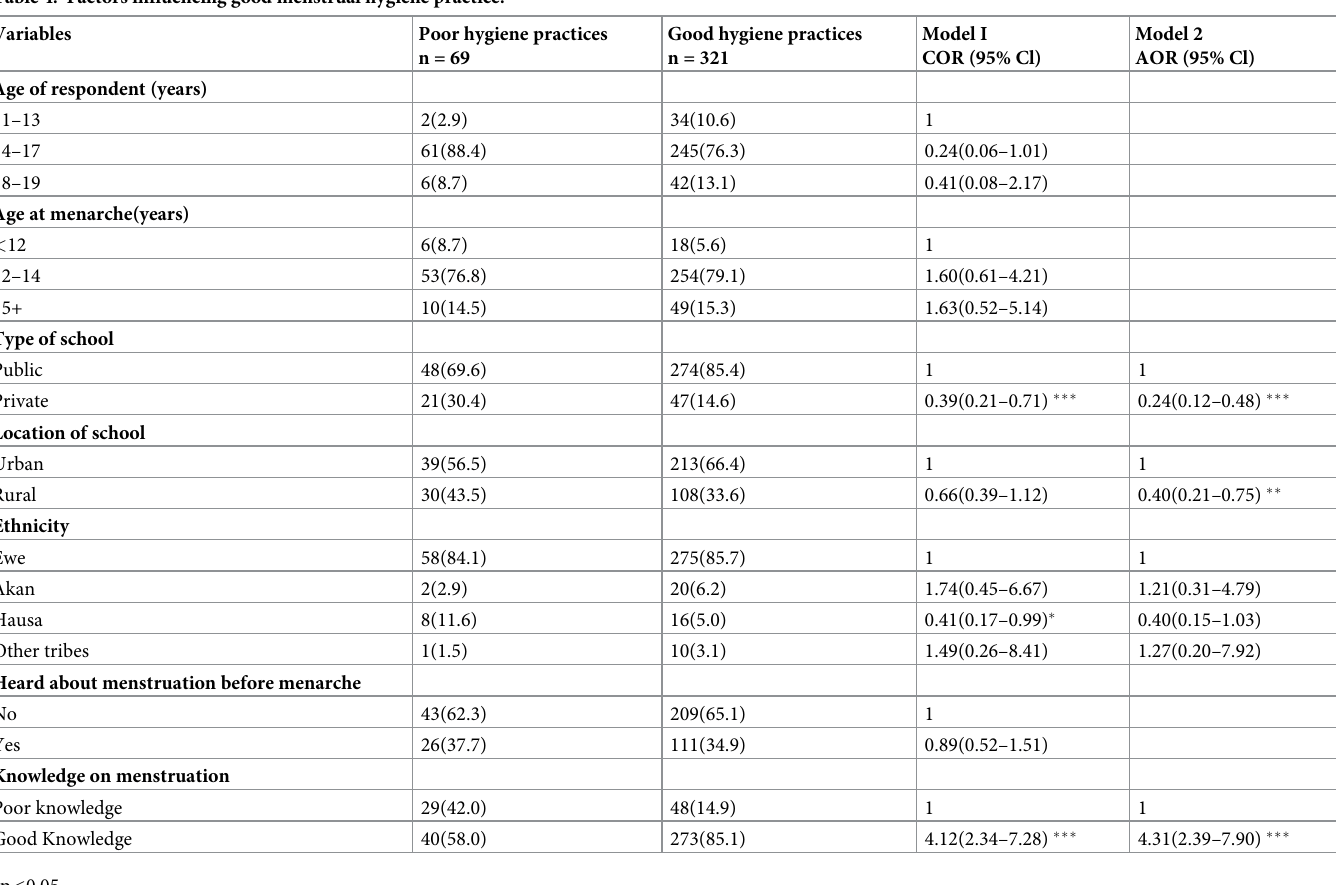
Table 4. Factors influencing good menstrual hygiene